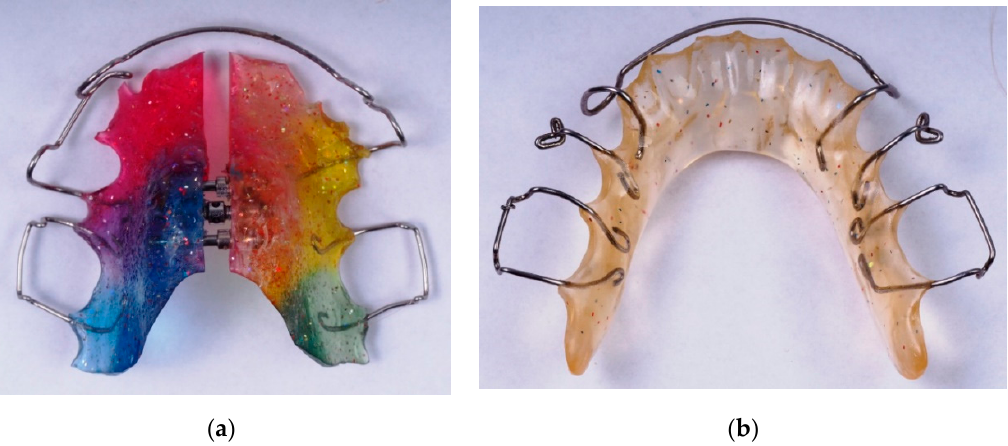
Figure 1. Examples of biomechanical orthodontic appliances: ( a ) upper Shwarz apliance, ( b ) lower Shwarz apliance.